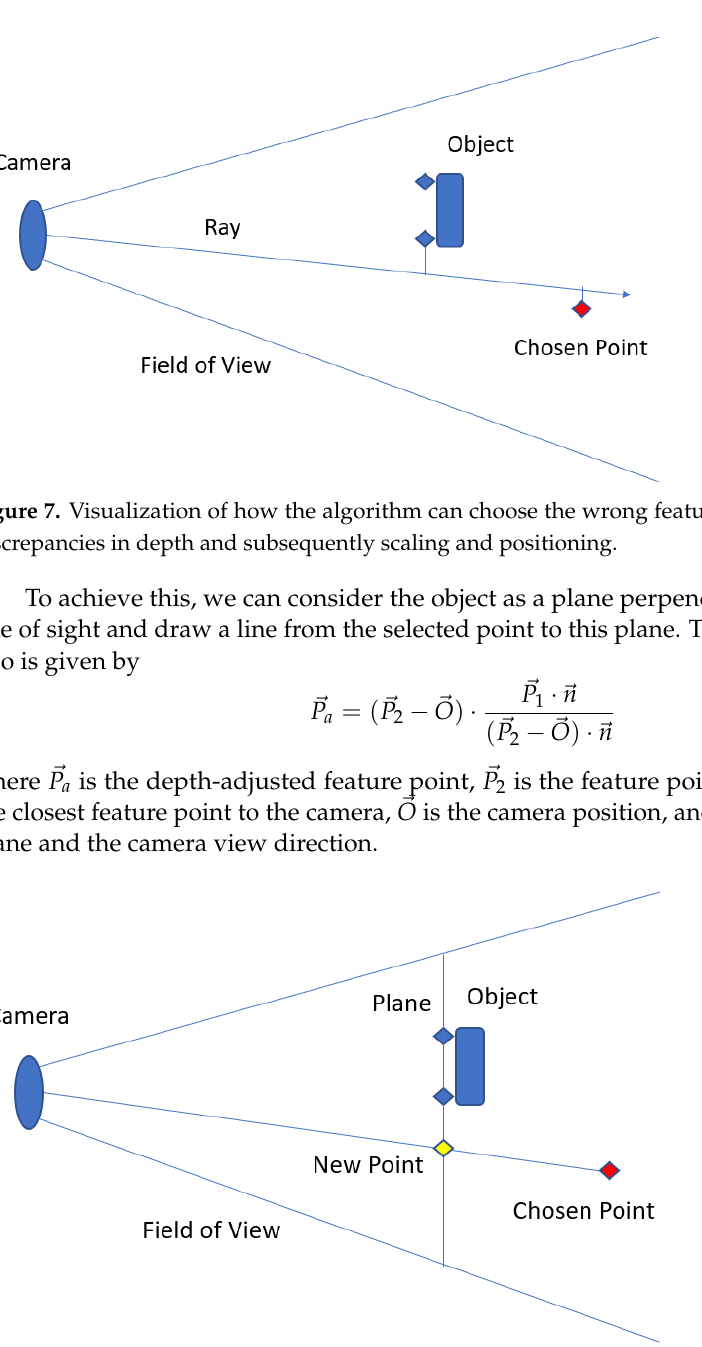
Figure 8. Visualization of how the algorithm accounts for depth discrepancies and chooses a better suited point for the scaling and positioning of the virtual